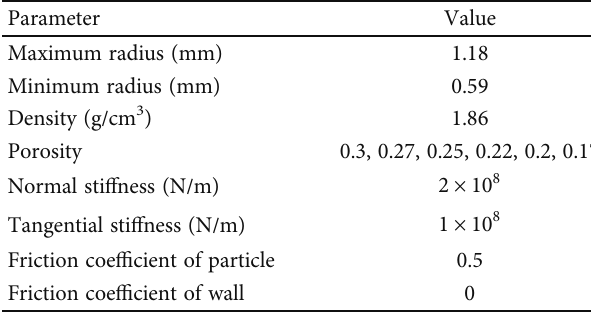
Figure 7: Numerical model of direct shear test through PFC2D. Table 4: Microscopic parameters of PFC